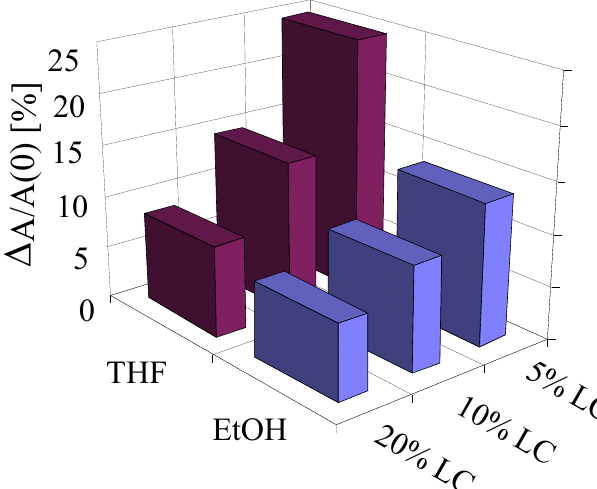
Figure 6. Imprinting of different amounts of CLCs embedded in cross linked polyvinyl dibenzene showing that 5% gives better selectivity than